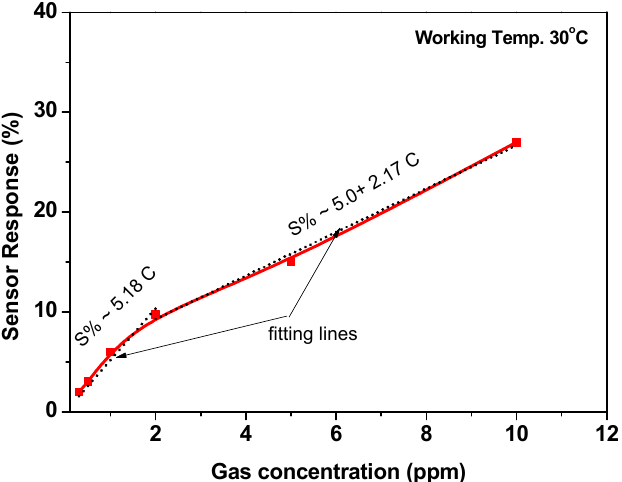
Figure 9. Sensor response as a function of gas concertation at a working temperature of 30 °C. The response and recovery time constants are very important parameters for describ- ing the features of the sensor. These constants are defined as the time taken for resistance to reach 90% of its equilibrium (response/recovery), as demonstrated in the inset of Figure 10. The response and recovery times are calculated as a function of the gas concentration for the signal that is reported in Figures 7 and 8. The response time constant (black mark) is about 60 s at a gas concentration of 0.3 ppm and it increased up to ~110 s at 10 ppm, as plotted in Figure 10. The recovery time constant (red mark) is ~120 s at a low concertation of 0.3 ppm and it increased linearly with an increasing the gas concentration. The response and recovery of the sensor are fast and reasonable.